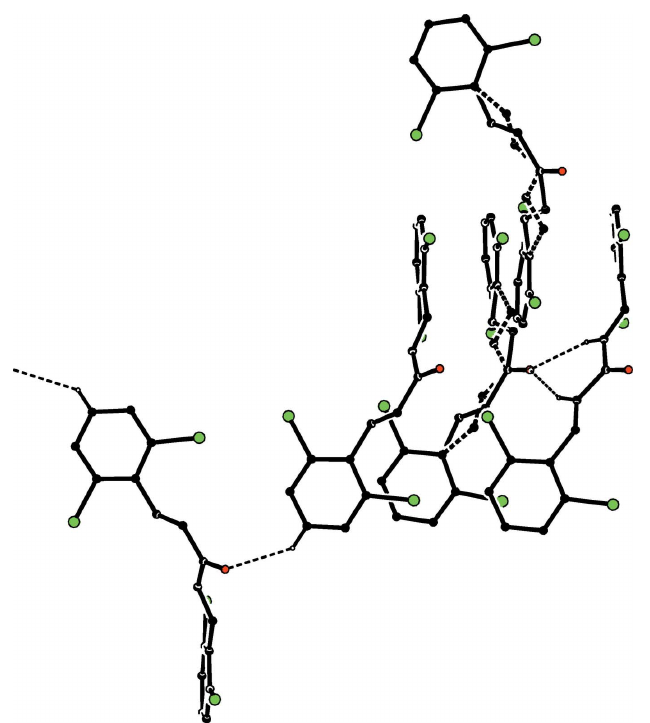
Figure 2 Crystal packing of the title compound. The dashed lines indicate hydrogen bonding. Hydrogen atoms not involved in hydrogen bonding are omitted for clarity.